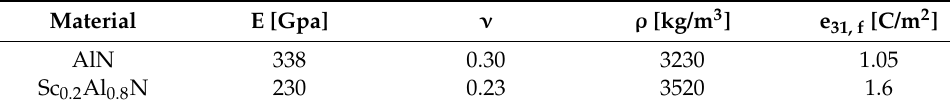
Table 1. The material parameters used in FEM simulations.